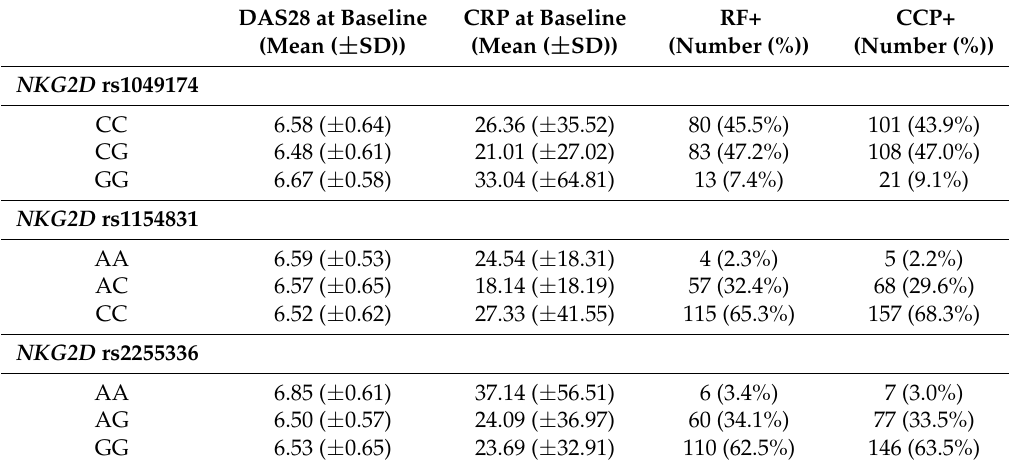
Table 3. Distribution of the NKG2D alleles and genotypes with regard to selected clinical parameters. Percentages calculated in regard to a total number of patients measured for a given feature.